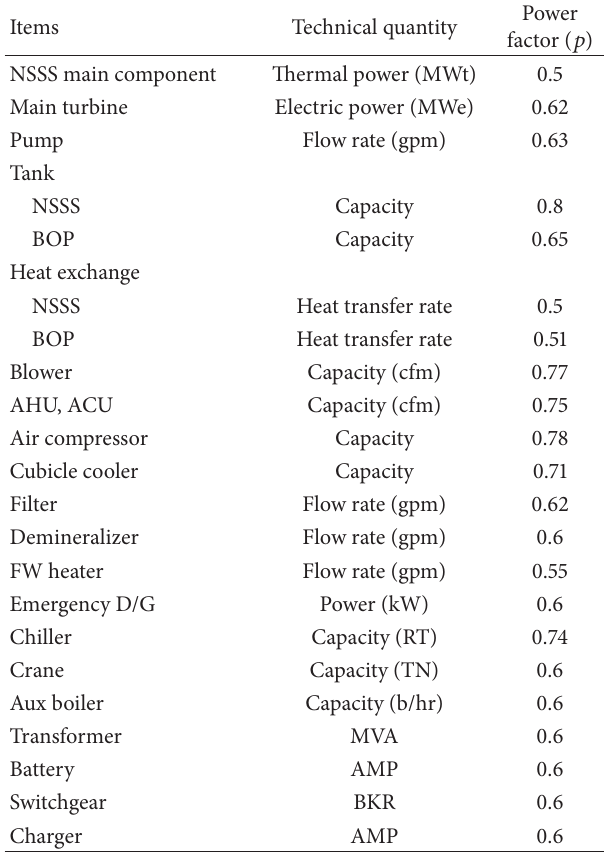
Table 9: Power factor of equipment in nuclear power plant.